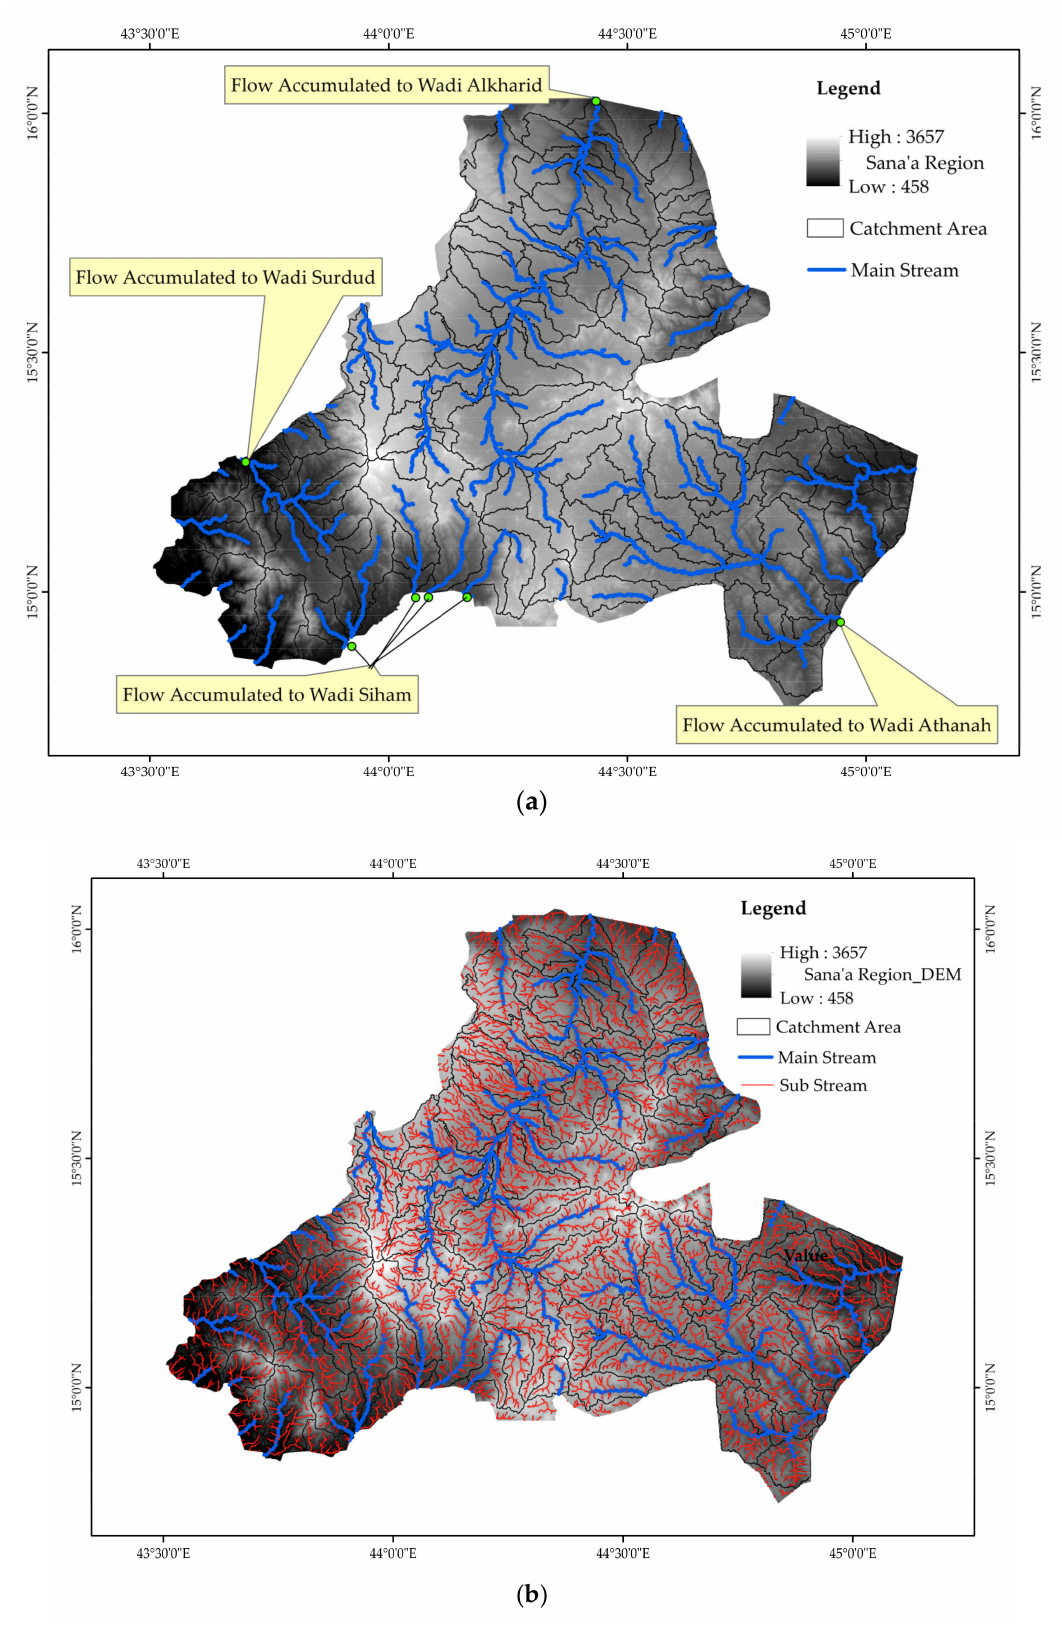
Figure 5. Main and sub-stream flow directions in Sana’a region: ( a ) Main stream with a catchment area; ( b ) Main and sub-stream with a catchment